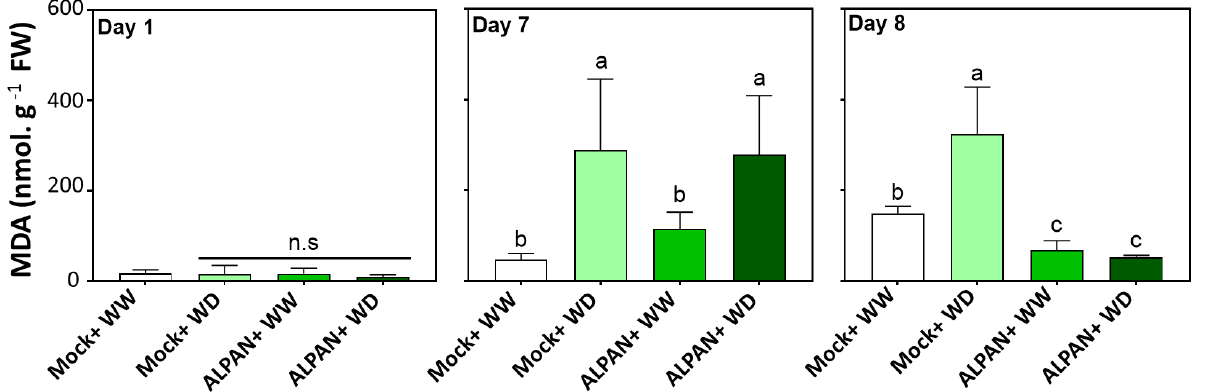
Figure 3. Malondialdehyde (MDA) concentration after 1, 7, and 8 days of the initiation of the water deficit stress. WW = well watered, WD = water deficit; FW = fresh weight; n.s = not significant. Error bars above histogram columns represent the standard deviation of four independent biological replicates in each experimental group at each sampling timepoint. The statistical data were analyzed with the use of the one-way ANOVA and Tukey’s post hoc tests, and a statistically significant difference ( p -value < 0.05) is denoted by a different letter above a histogram column.